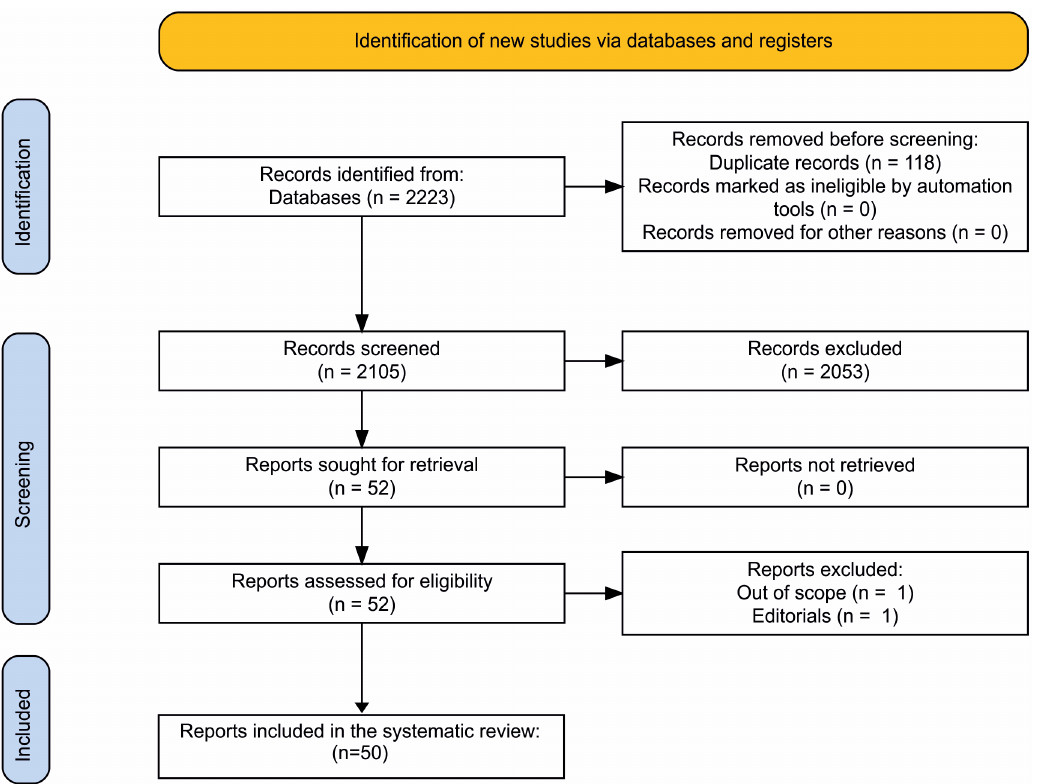
Figure 1. PRISMA 2020 flowchart diagram. Created using an online tool: https://estech.shinyapps.io/prisma_flowdiagram/ (accessed on 8 December 2022).